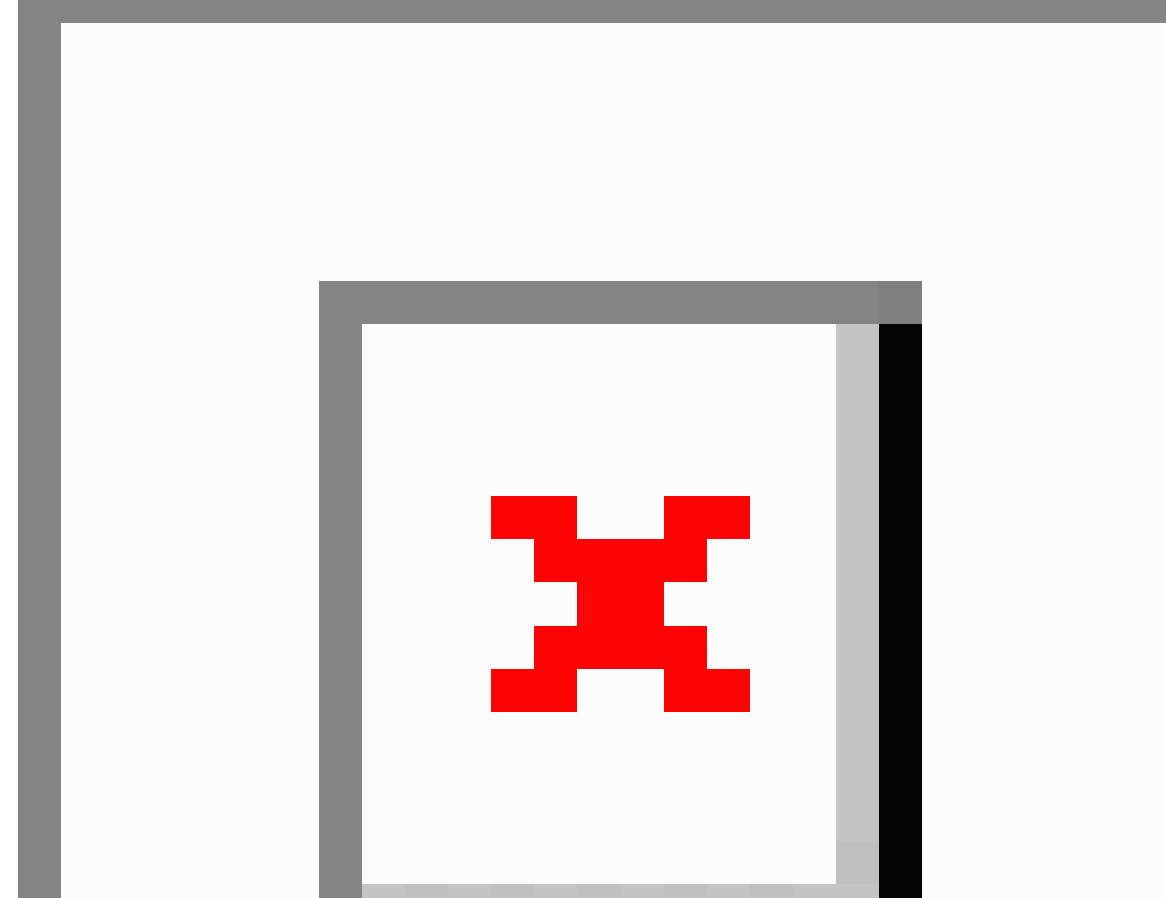
Figure 6. Forest plot of standardized mean differences of the effect on general distress of Internet-based cognitive behavioral therapy compared with a passive control